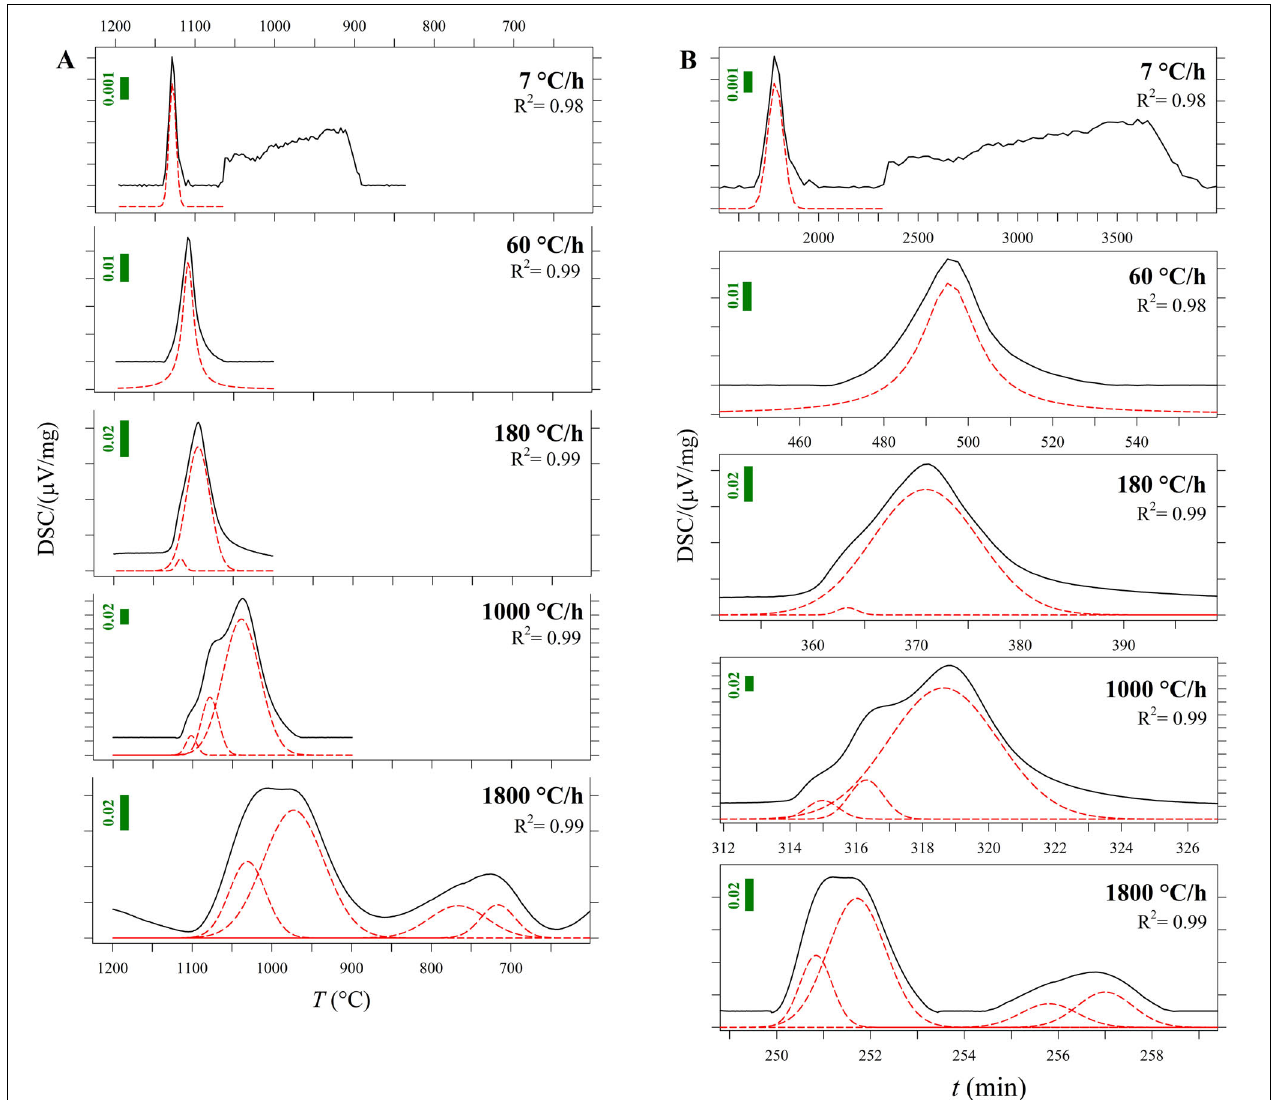
FIGURE 2 | (A) Zoom-in of DSC curves as a function of temperature ( T ) from Figure 1 and Supplementary Figures S1A–E (blue lines). The fitted components of these peaks are plotted in red and listed in Table 3 . Vertical bars show the Y-axis scale. (B) DSC curves as a function of time ( t ). The fitted components of these peaks are plotted in red and listed in Table 3 . Vertical bars show the Y-axis